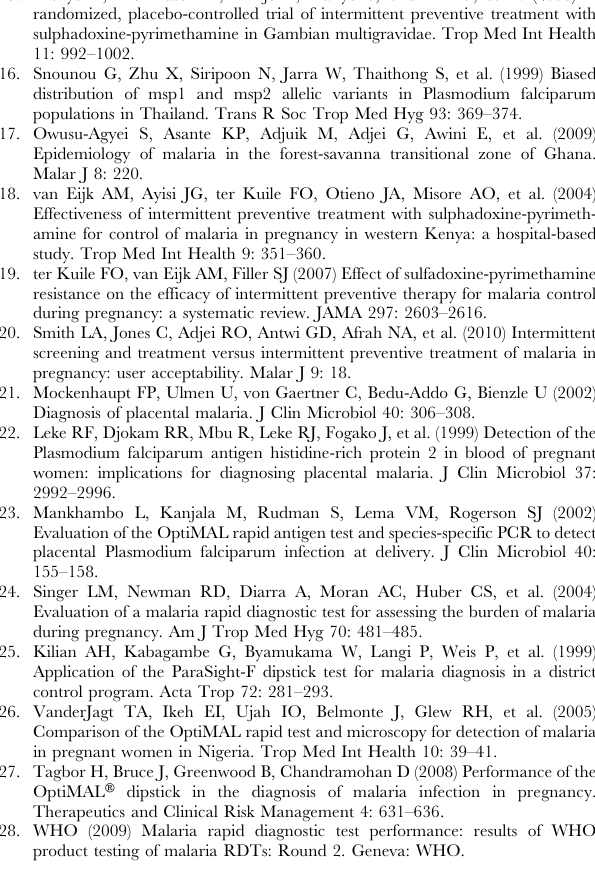
Table S2 Comparison of pregnancy outcomes for singleton births.